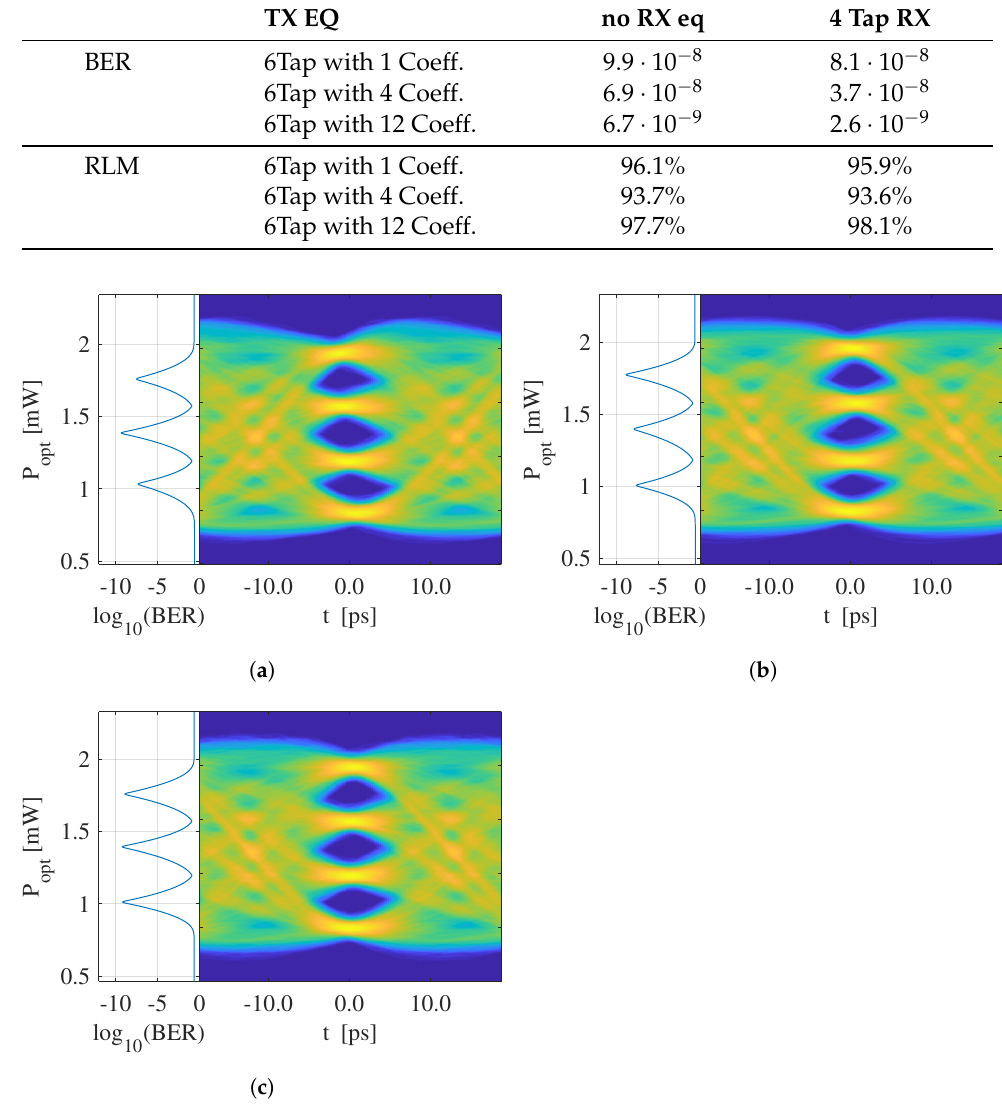
Figure 11. 80 Gbit/s eye diagrams with additional four taps linear FFE in the receiver using six TX taps of ( a ) linear FFE, ( b ) adaptive FFE with four sets of coefficients and ( c ) adaptive FFE with 12 sets of